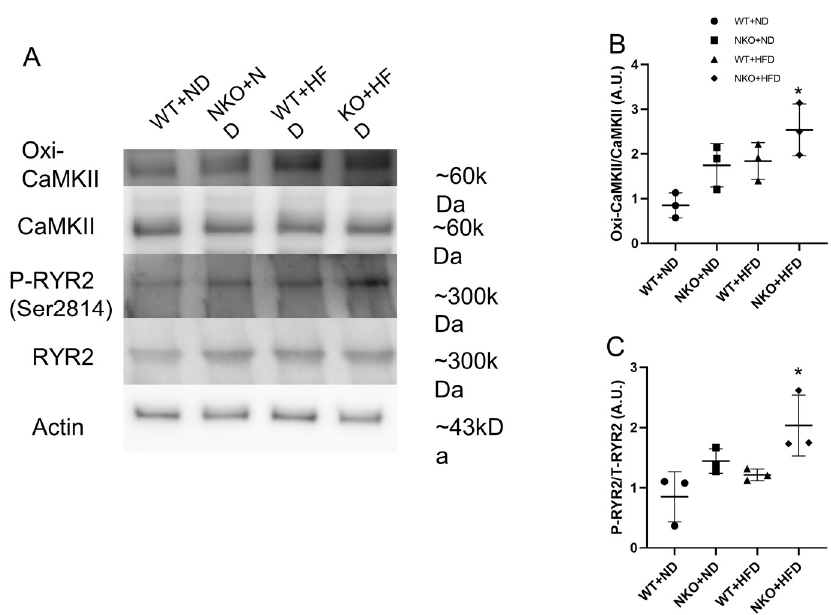
Figure 5. Western blotting of calcium handling pathway-related molecules. ( A ) Representative western blots for proteins with key roles in the calcium handling pathway. β -Actin was assessed as an internal control. ( B ) Ratios of oxidized CaMKII to total CaMKII. ( C ) Ratios of phosphorylated RyR2 to total RyR2. * p < 0.05 vs. WT + ND mice ( n = 3 per each groups). Statistical comparisons between multiple groups: one-way ANOVA followed by a post-hoc Bonferroni test.